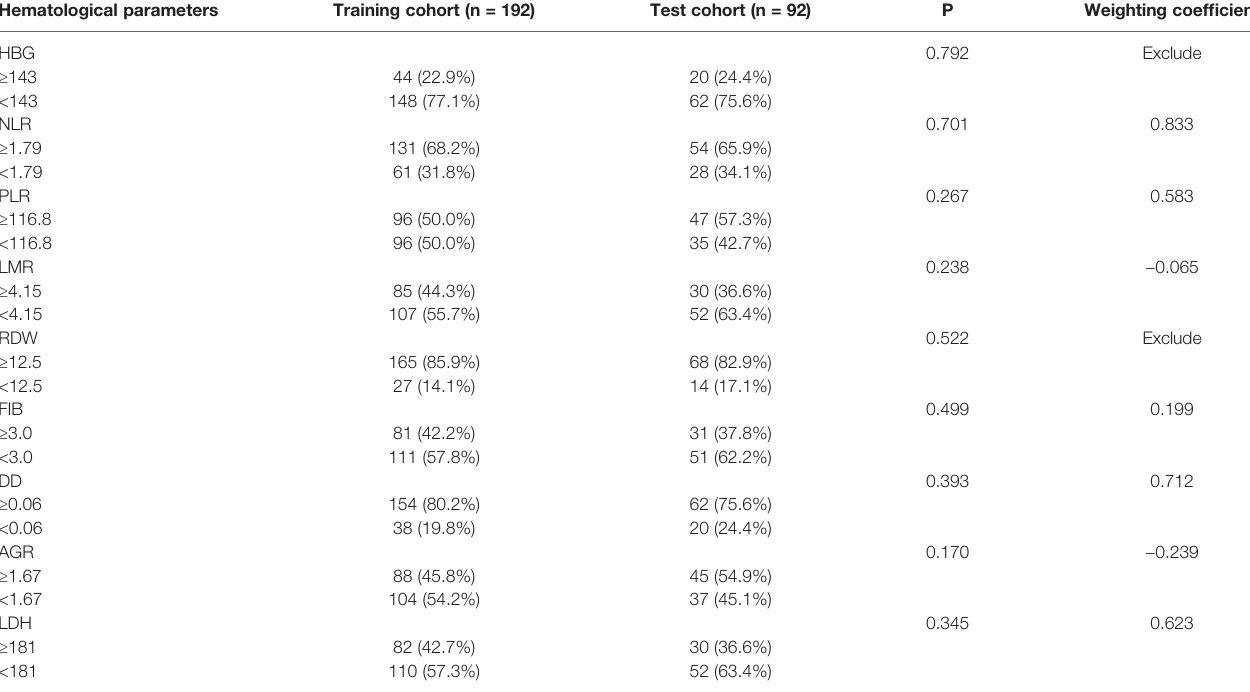
HBG,hemoglobin;NLR,neutrophil-to-lymphocyteratio;PLR,platelet-to-lymphocyteratio;LMR,lymphocyte-to-monocyteratio;RDW,redblooddistributionwidth;FIB, fi brinogen;DD,D- dimer;AGR,albumin-to-globulinratio;LDH,lactatedehydrogenase.Referencerange:HBG115 – 150g/L;RDW(1 – 20)%;FIB2 – 4g/L;DD0 – 0.3 m g/ml;ALB35 – 55g/L;GLOB20 – 35g/L; LDH 75 – 245